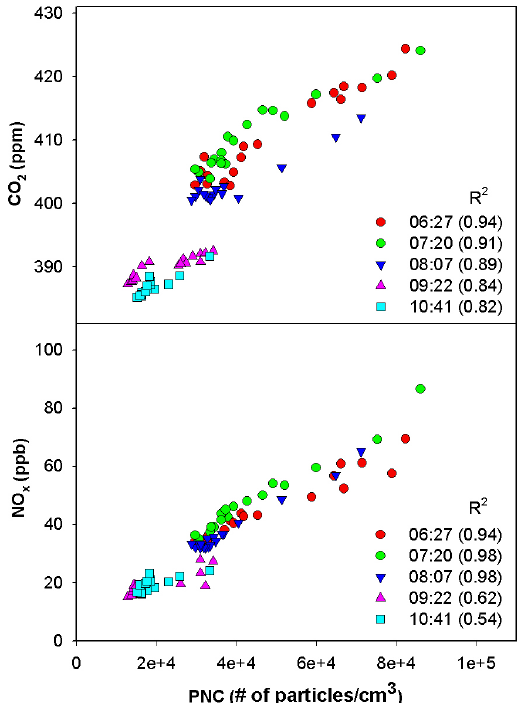
Fig. 4. Relationship between CO 2 and PNC and between NO x and PNC measured downwind of I-93 throughout the morning on 16 January 2008. Correlation coefficients ( R 2 ) are shown in the leg- ends.